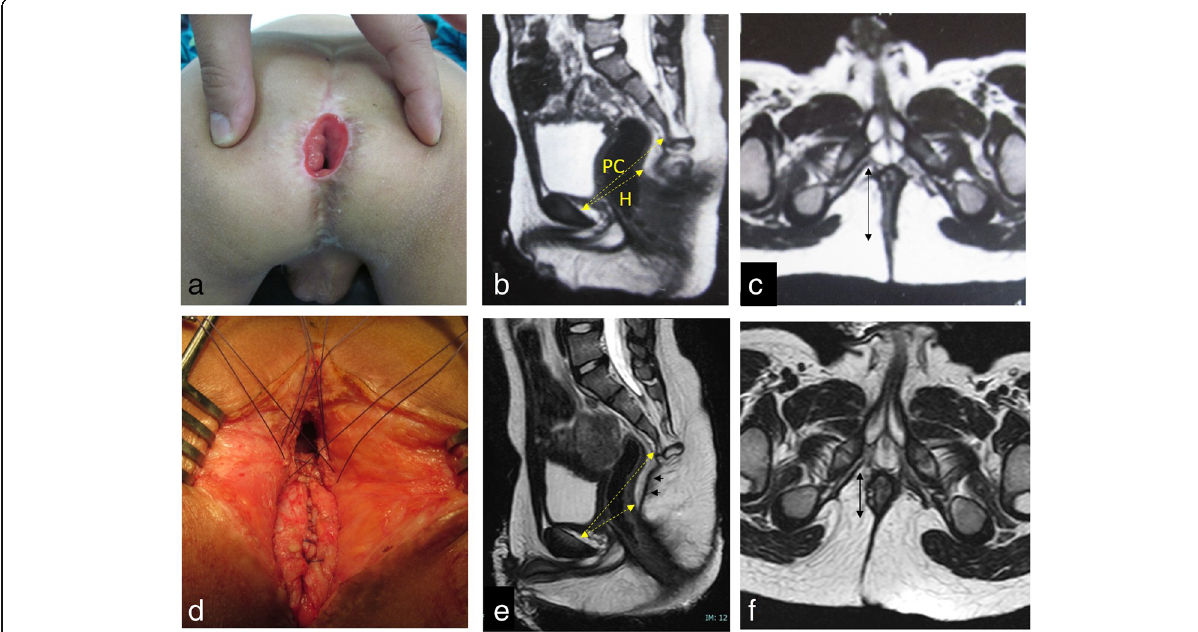
Fig. 1 Five-year-old boy presenting with faecal incontinence after PSARP. a Patient in the prone position, note the patulous anus. b Mid sagittal pelvic MRI (T2WI) demonstrating wide pelvic hiatus (H) with reference to Pubo-Coccygeal distance (PC); [calculated H/PC ratio = 0.7]. c Axial pelvic MRI (I-plane) demonstrating elongated transverse section of the anorectum (double arrow-head line). d Patient placed in the prone position at reoperation (Redo PSARP): reconstruction of the pelvic floor by re-approximation of the split halves of the diaphragmatic part of the levator ani behind the anorectum. Note: posterior tapering of anorectum. e , f Follow-up MRI (midsagittal and axial, respectively) performed 3 years later after reoperation demonstrating the effect of redo surgery on the internal pelvic MRI anatomy; note: short black arrows are pointing to the reconstructed levator plate behind anorectum; calculated [H/PC ratio = 0.58] (compare with b , c